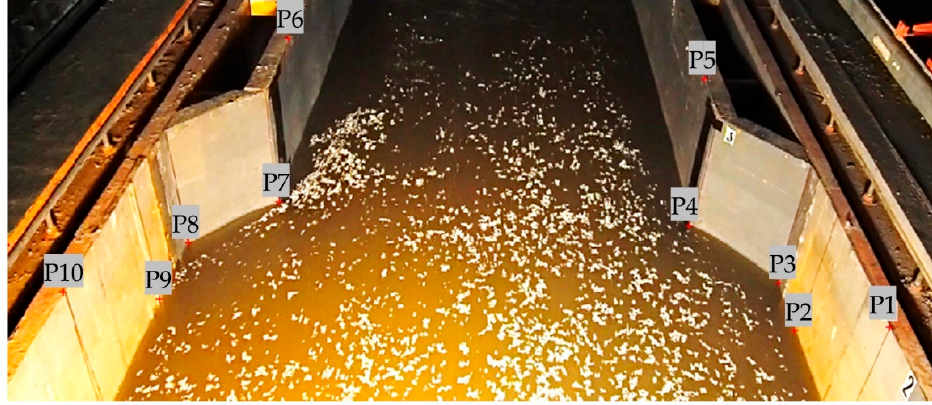
Figure 2. Locations of GRPs for 0.75 contraction ratio. The locations are designated as P1 through P10.